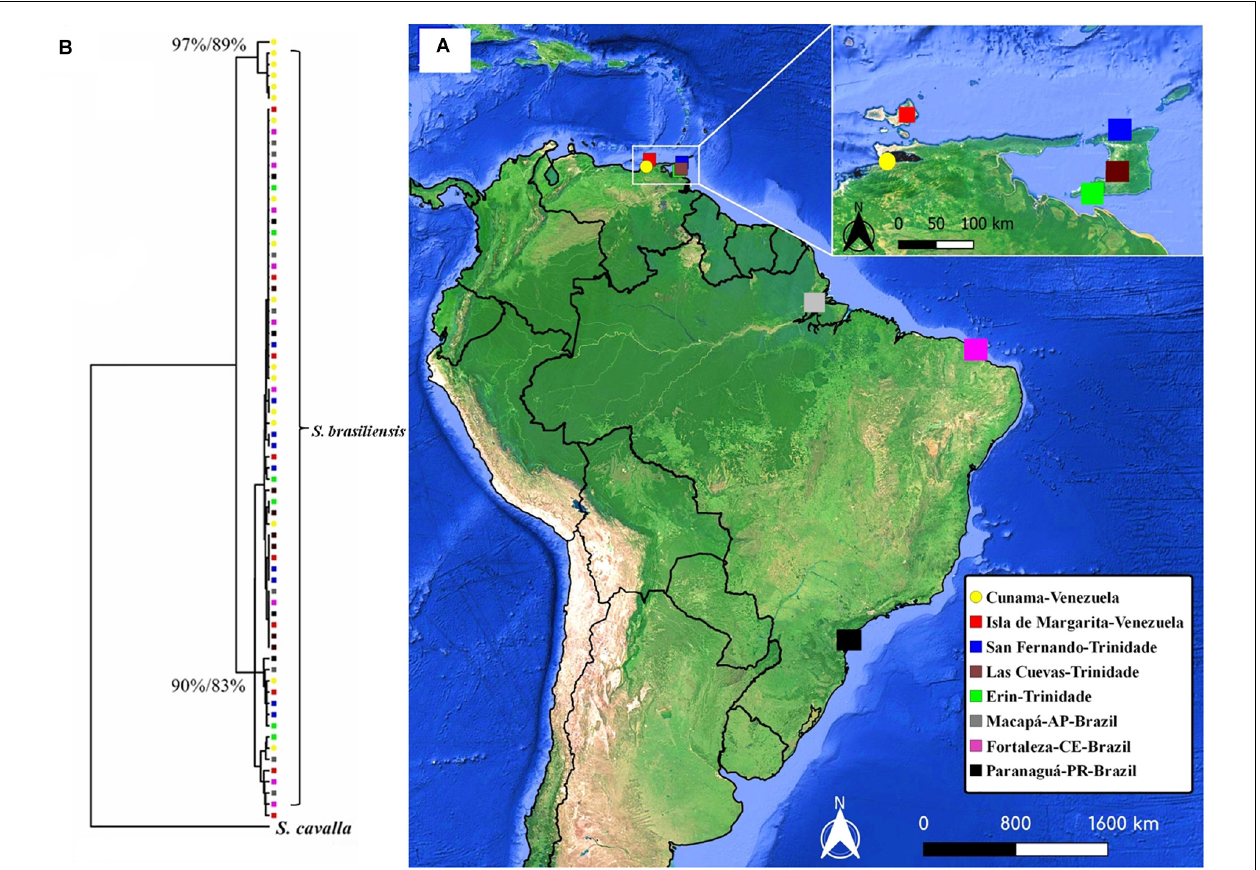
FIGURE 1 | (A) Map of South America showing the eight sites from which the specimens of S. brasiliensis analyzed in the present study were obtained: 1- Cumana; 2- Isla de Margarita; 3- San Fernando; 4- Las Cuevas; 5- Erin; 6- Macapá; 7- Fortaleza and 8- Paranaguá. (B) Neighbor-Joining and Maximum Likelihood trees for the Scomberomorus brasiliensis haplotypes of the MT-ND4 gene. Each haplotype is represented by a different color, yellow circles = 1- Cumana, red squares= 2- Isla de Margarita, blue = 3- San Fernando, brown = 4- Las Cuevas, green = 5- Erin, gray = 6- Macapá, pink = 7- Fortaleza and black = 8- Paranaguá.